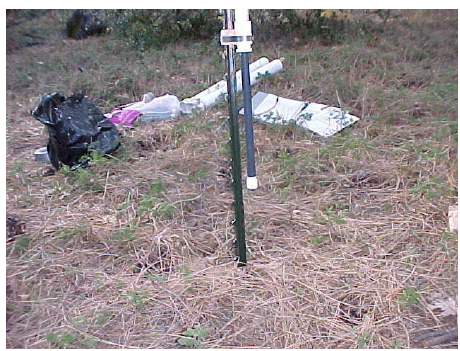
FIGURE 2 . Close-up view of the ion exchange resin column in a typical winter